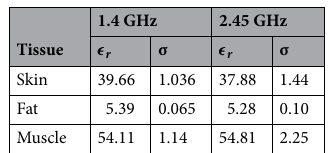
Table 2. Electrical properties of biological tissues 23,31,32 .